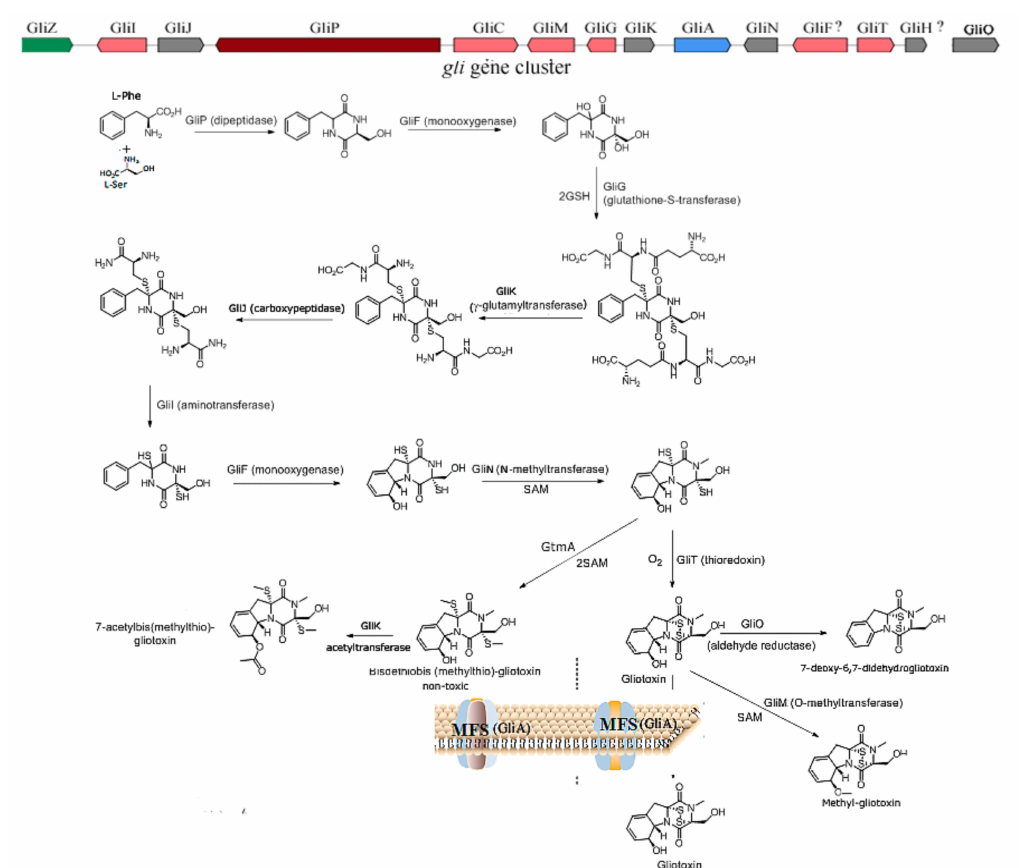
Figure 1. The proposed biosynthetic pathway of gliotoxin and its derivatives [16]. The gli gene cluster depicts the biosynhetic pathway of gliotoxin in A. fumigutas, the coding protein for each gene was annoated in the biosynthetic pathway of gliotoxin and thereof derivatives. The SAM refers to S-adenosylmethionine, MFS refers to major facilitator superfamily. GtmA refers to